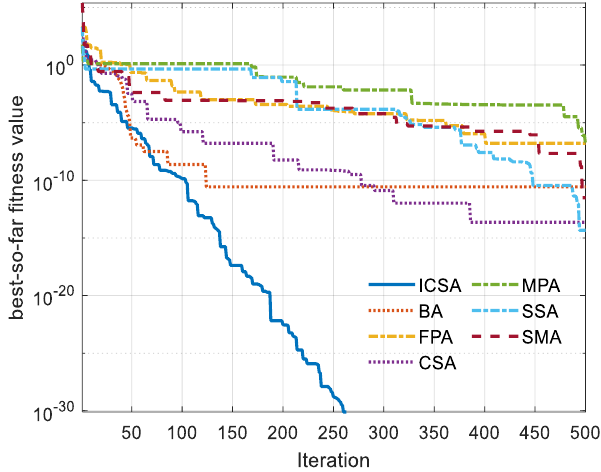
Figure 9. Convergence curve for F9.